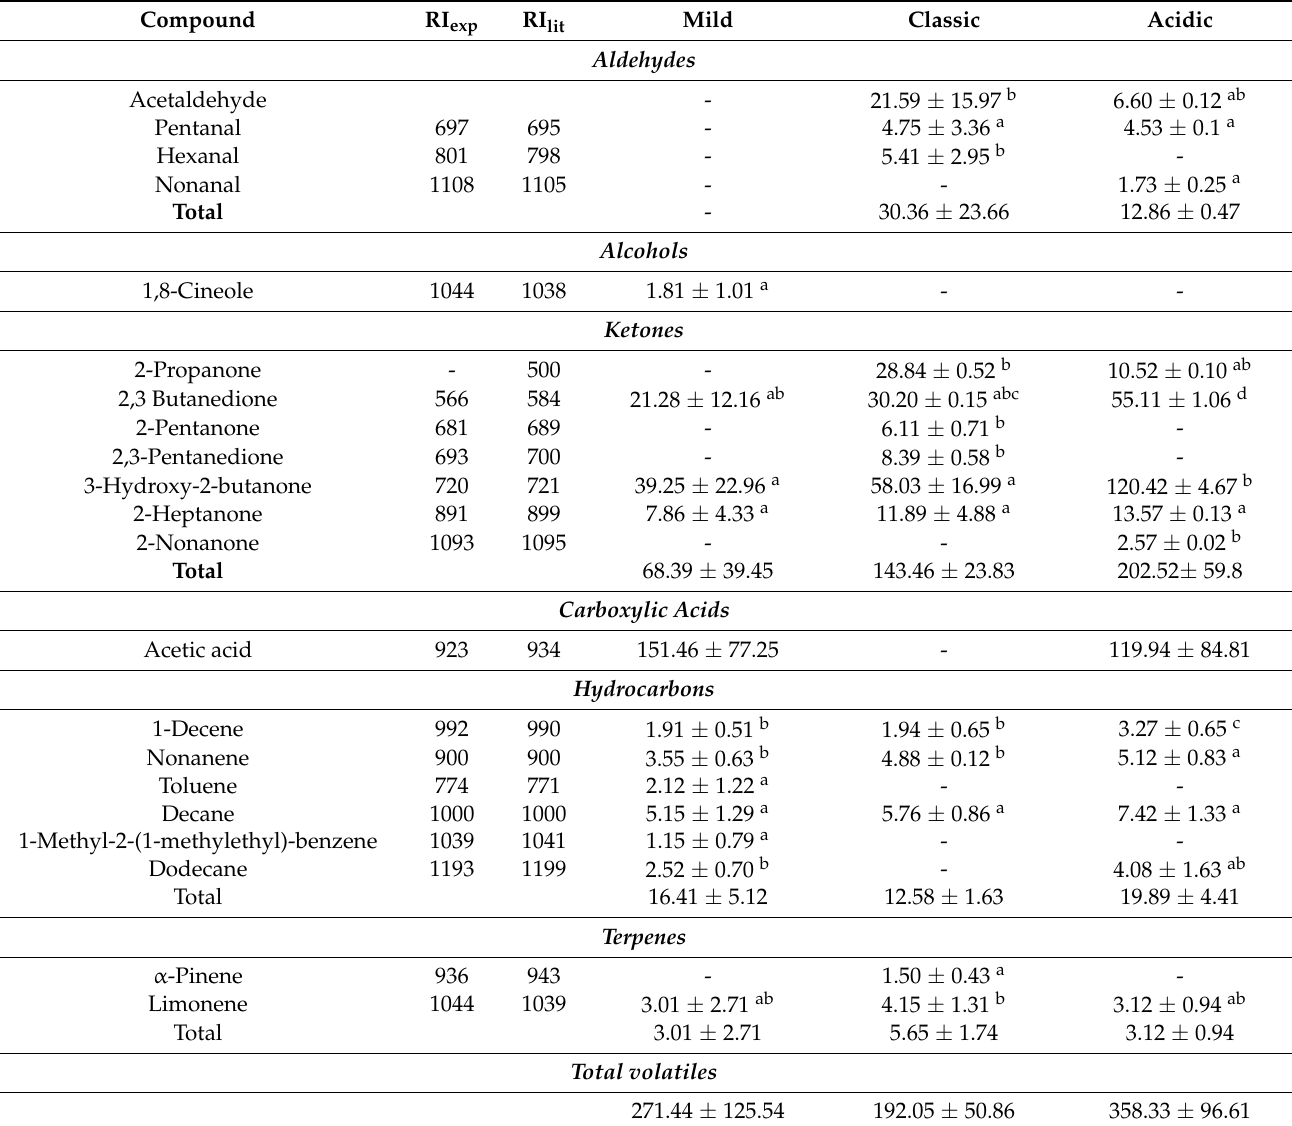
Table 2. Volatile compounds of cow dessert yogurts (mg kg − 1 ), prepared with different cultures with the addition of Bifidobacterium animalis ssp. lactis BB-12.